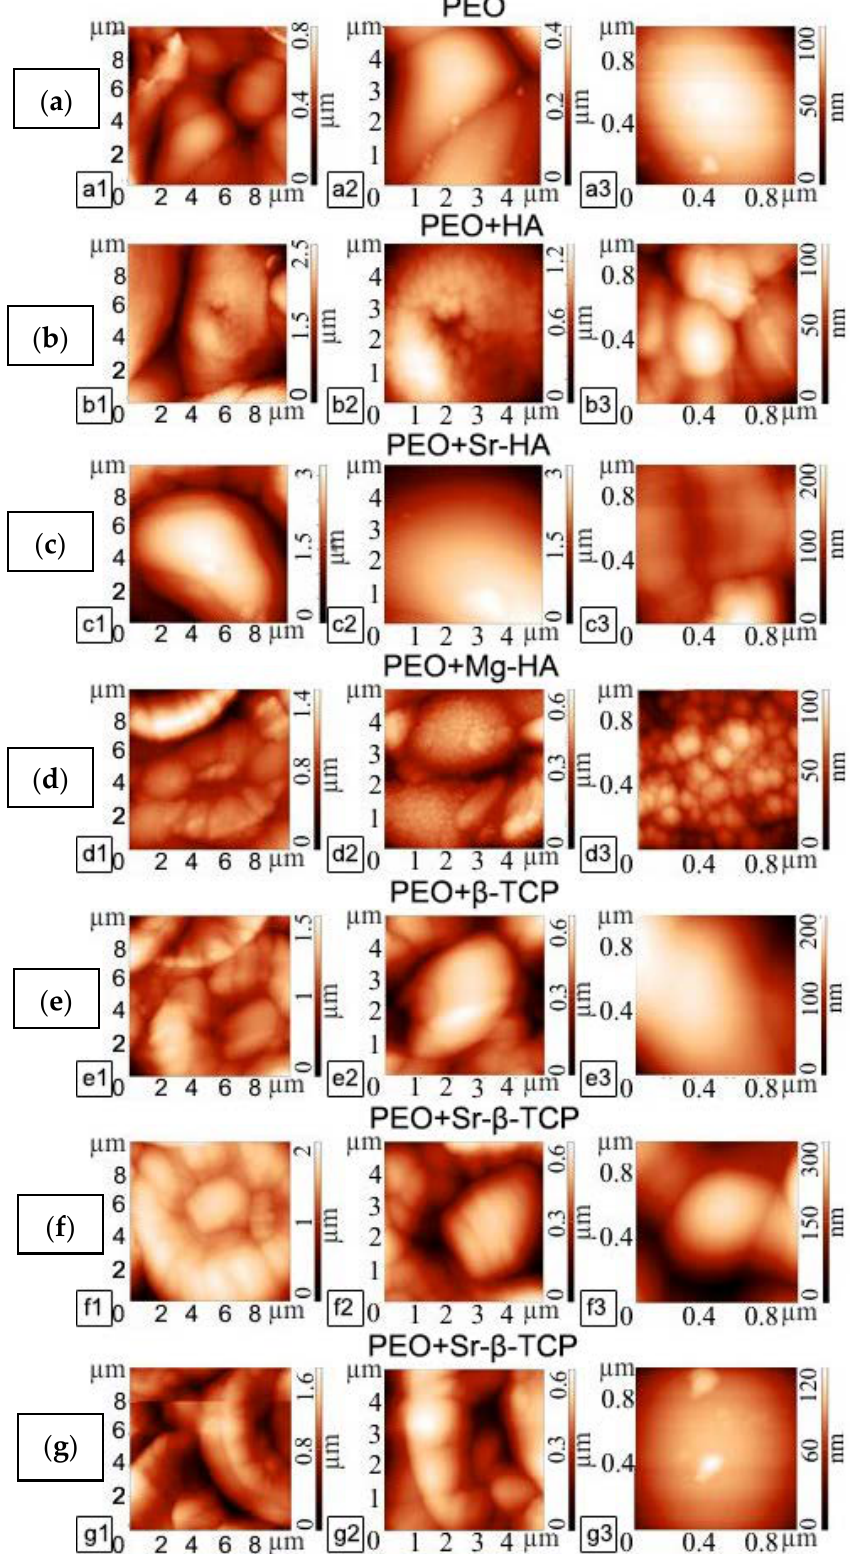
Figure 2. AFM images of CaP PEO ( a ) and composite PEO + RF coatings sputtered with HA ( b ), Sr-HA ( c ), Mg-HA ( d ), β -TCP ( e ), Sr- β -TCP ( f ), and Mg- β -TCP ( g ) targets.